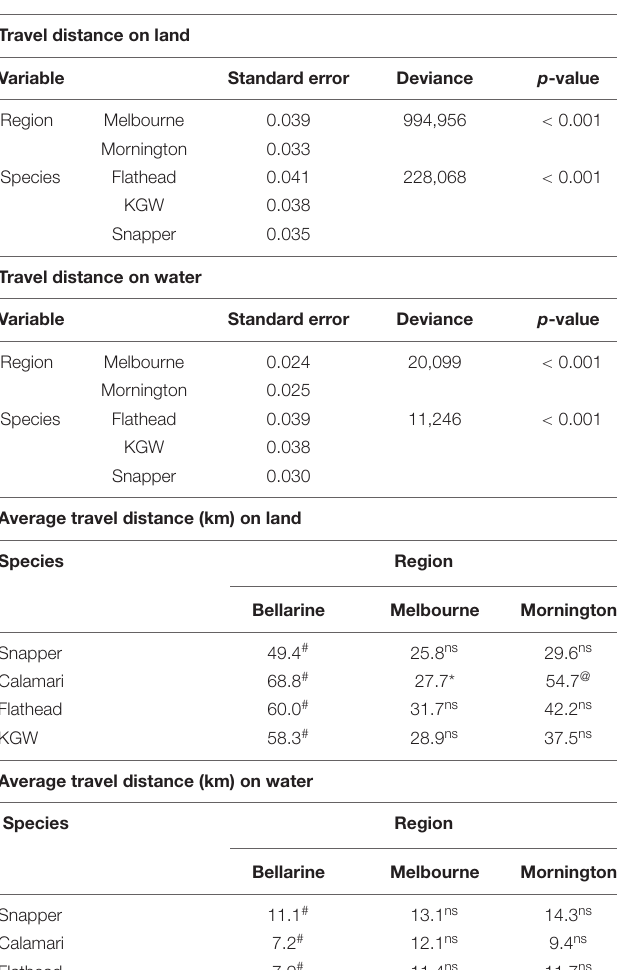
TABLE 3 | Summary statistics of generalized linear models (GLM) describing travel distance on land and water by region and species, and statistical differences in average travel distance (km) on land and water between regions by target species in PPB.